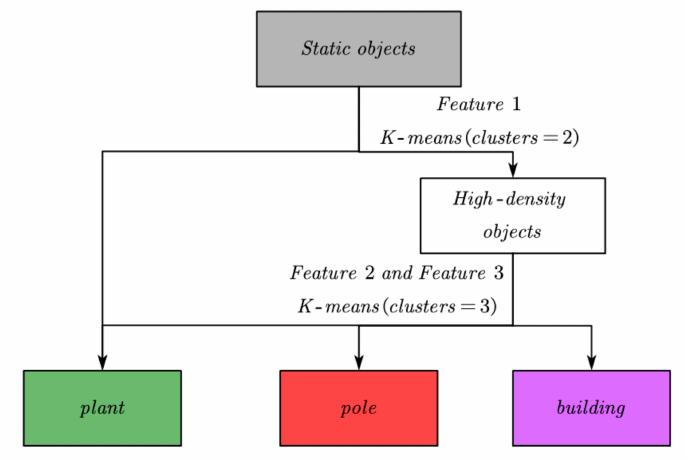
Figure 17. The process of labeling static objects.